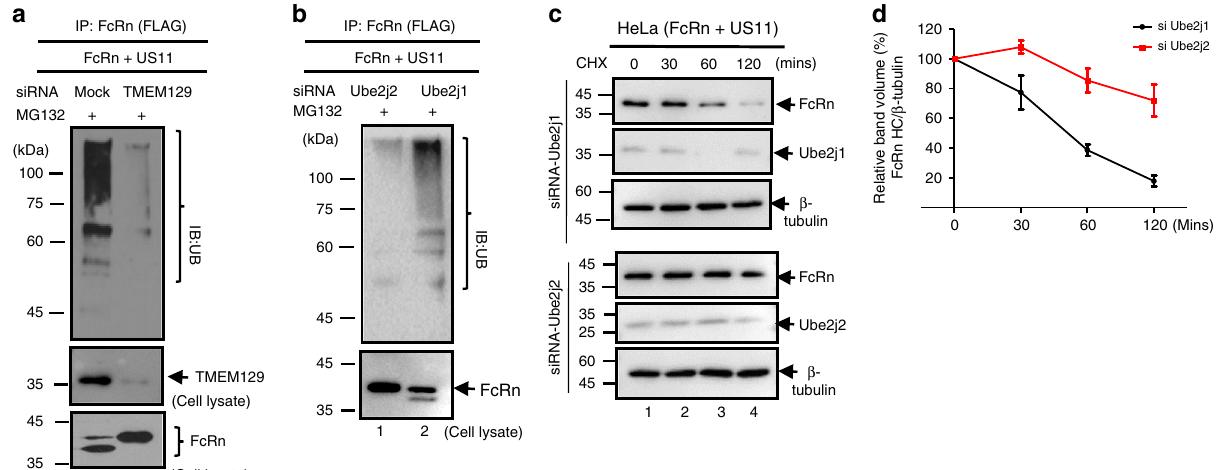
Fig. 7 TMEM129 and Ube2J2 are required for US11-induced FcRn ubiquitination, a , b TMEM129 and Ube2J2 is required for US11-induced FcRn ubiquitination. HeLa FcRn + US11 cells were transfected with 20 nM TMEM129, Ube2J1, or Ube2J2 siRNA oligomers for 48 h or empty vector. Cells were subsequently treated with 50 μ M MG132 for 4 h and then lysed. All immunoprecipitates or cell lysates (20 μ g) as internal controls were subject to western blotting with corresponding Abs as indicated. c , d HeLa US11 + FcRn cells were transfected with 20 nM Ube2J1 ( c , top) and Ube2J2 ( c , bottom) siRNA oligomers for 48 h. Cells were then treated with CHX (100 μ g/ml) and chased for the indicated time. The cells were lysed after CHX treatment and cell lysates (20 μ g) were subject to western blotting with Abs as indicated. The level of remaining FcRn ( d ) in Ube2j1 siRNA-treated cells (black) or Ube2j2 siRNA-treated cells (red) was quanti fi ed as the percentage of the β -tubulin level at different time points. The percentage of time point 0 (min) is assigned a value of 100% and the values from other time points are normalized to this value. Error bars represented mean ± SEM of three independent